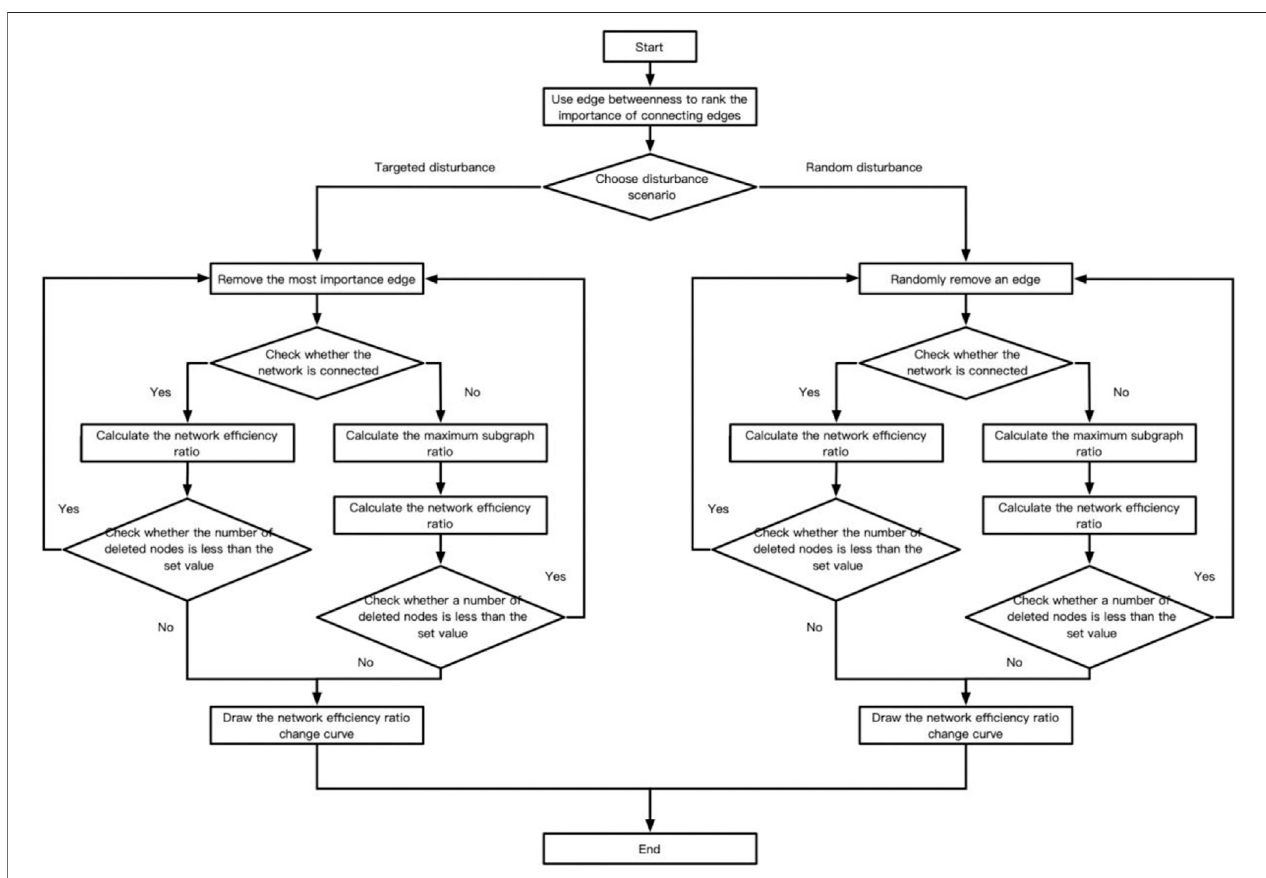
FIGURE 5 | Disturbance model one simulation algorithm fl ow